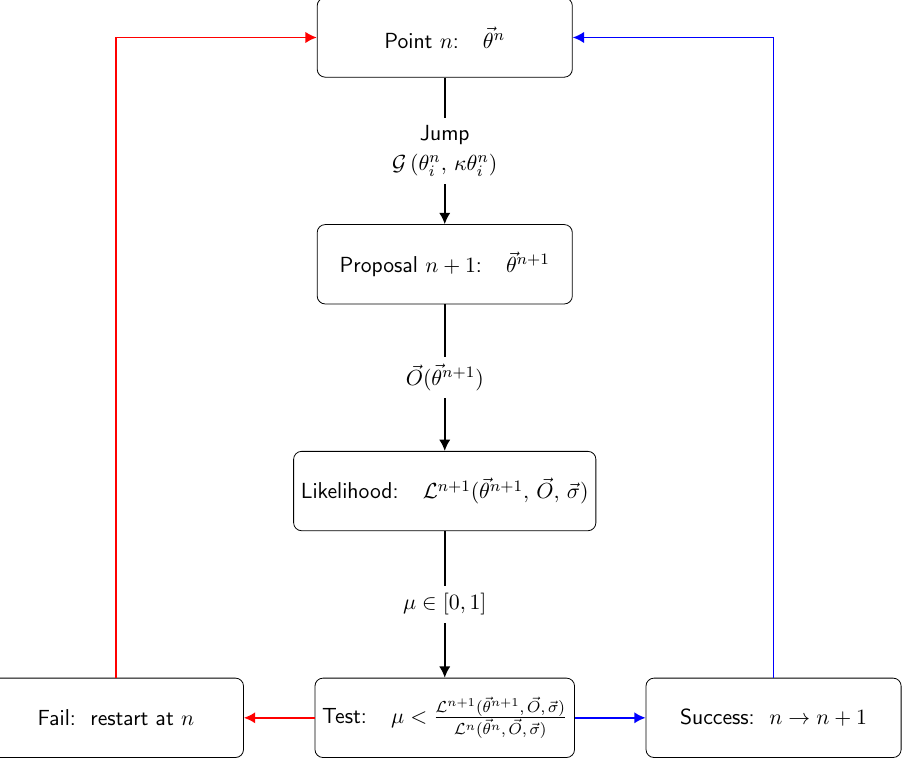
Figure 1 . Illustration of the MCMC algorithm